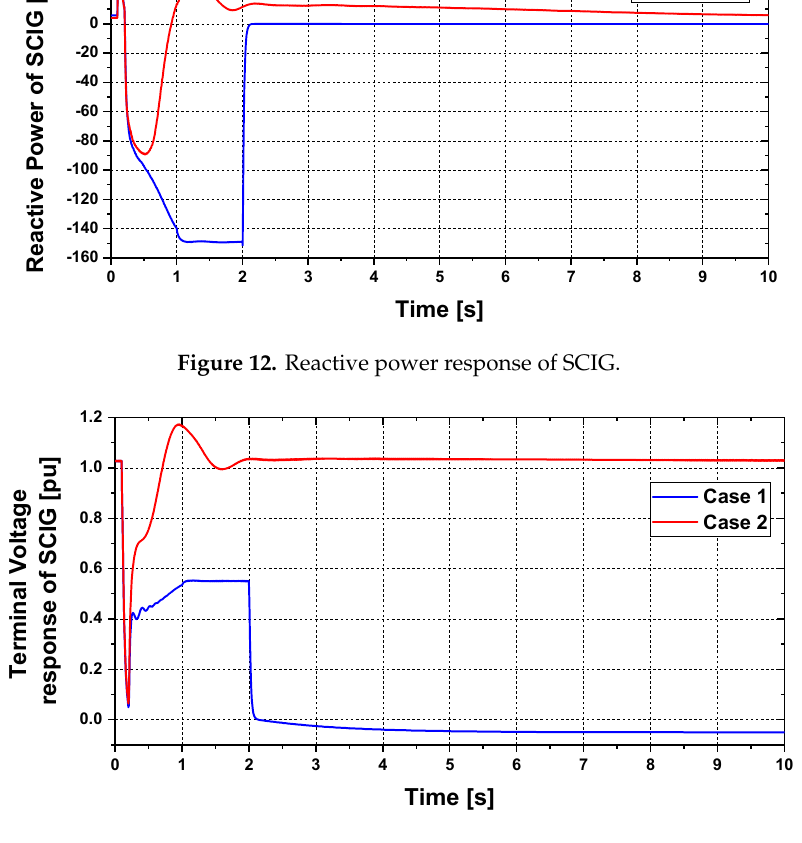
Figure 13. Terminal voltage response of SCIG.